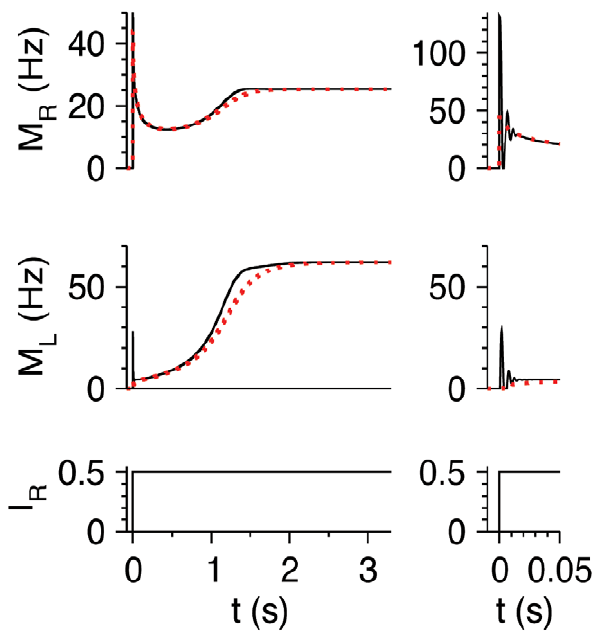
Figure 5. Effects of spike-frequency adaptation. The response of the RS-LTS network to step inputs I R H ( t ) to the RS neurons is shown by plotting the time courses of M R (top panels) and M L (middle panels) for I R =0.5 (bottom panels). Solid black lines represent the model with adaptation and dotted red lines represent the model without adaptation. The right top and middle panels depict the time course of M R and M L in a shorter time scale to emphasize the initial response to stimulus onset. Additional parameters are g RL =35, g LR =7.5, g RR =0.